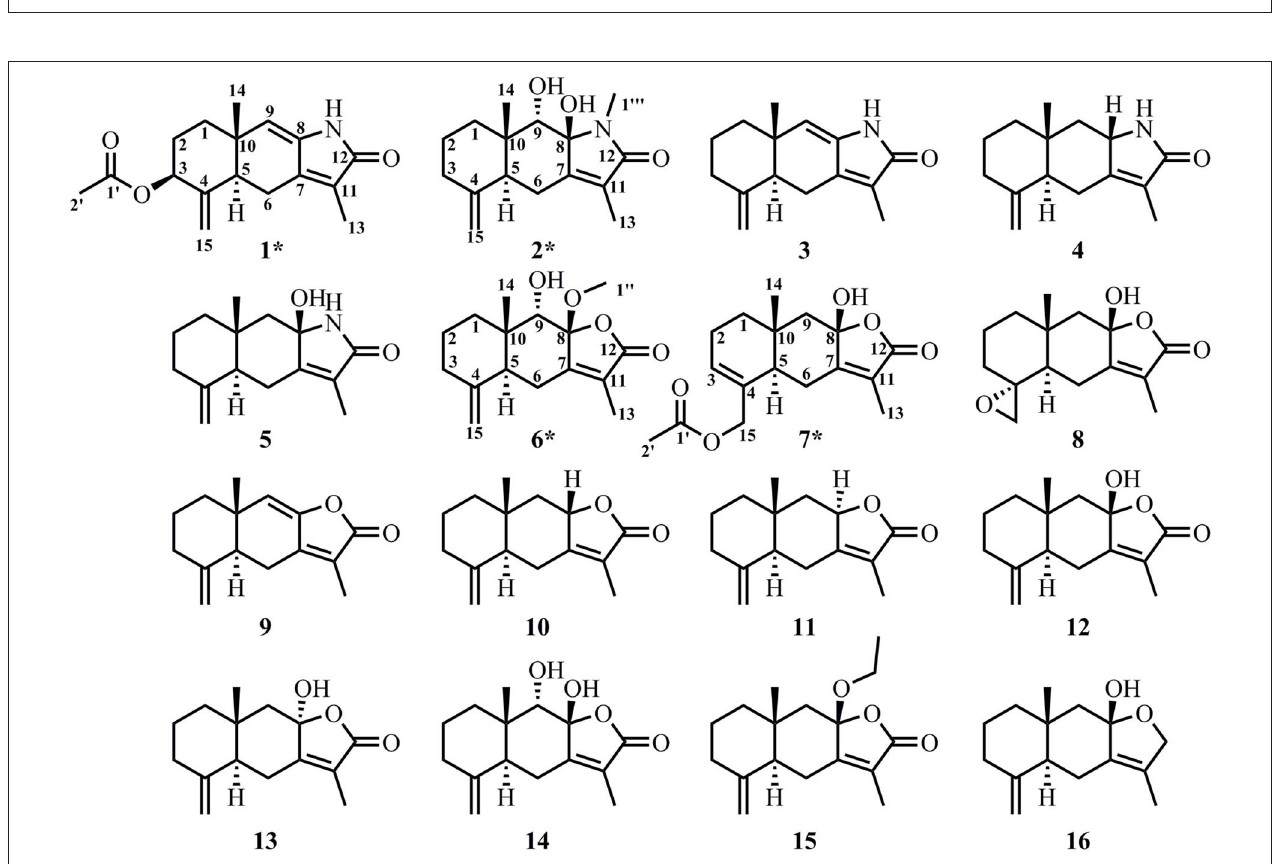
FIGURE 2 | Structures of compounds 1 – 16 identified in the rhizome of AM . The new compounds are marked with *.